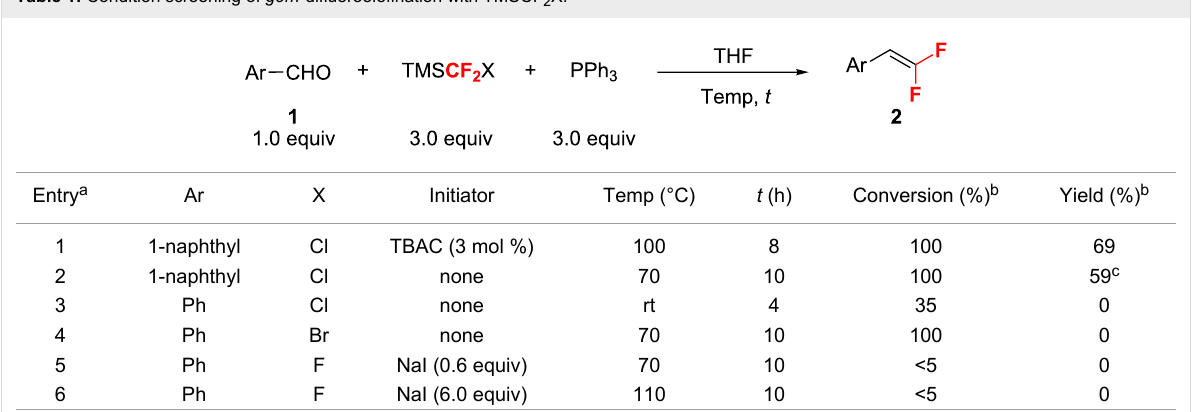
Table 1: Condition screening of gem -difluoroolefination with TMSCF 2